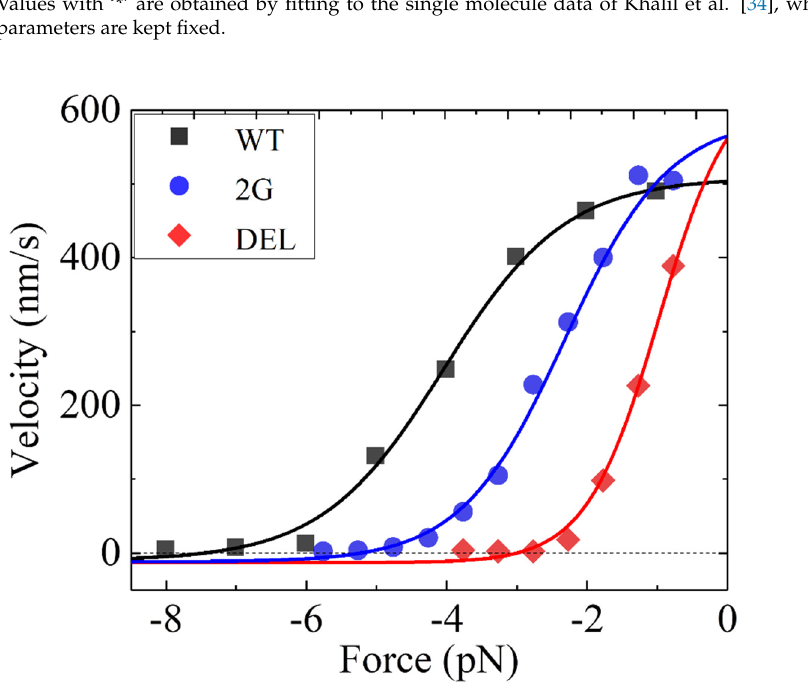
Figure 2. Dependence of velocity on backward load for Drosophila melanogaster kinesin-1 motors. WT, 2G, and DEL represent the wild type, the mutant 2G with two residues A9G and S12G in the cover strand, and the mutant DEL lacking the entire cover strand, respectively. Lines are theoretical results. Symbols are experimental data taken from Khalil et al. [34]. Table 1. Parameter values for Drosophila melanogaster kinesin-1 motors.